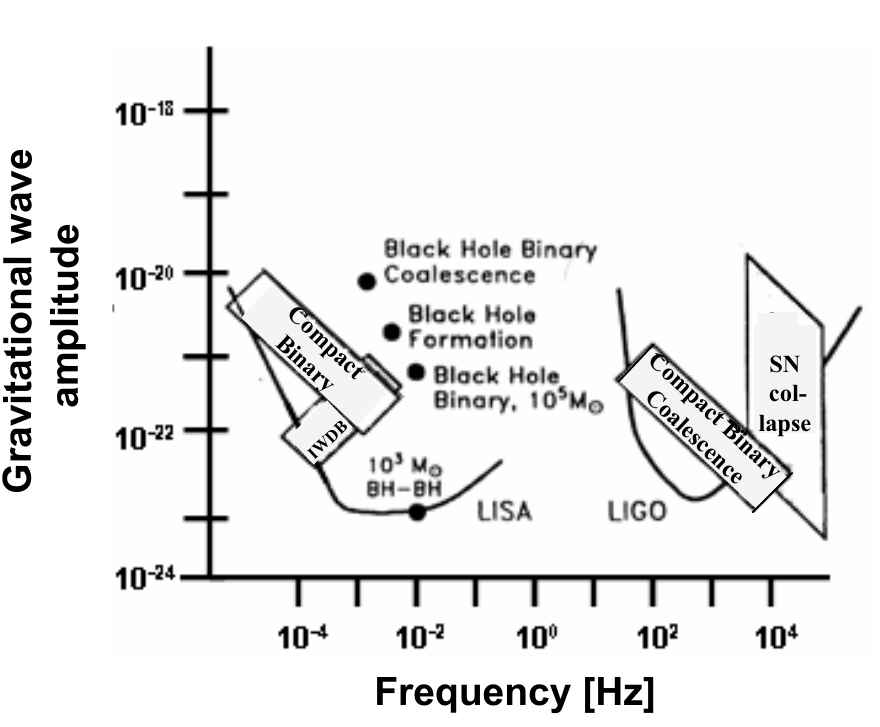
Fig. 6 – Detection efficiency (effective h versus frequency) of the space detector (LISA) and ground based ones under construction (VIRGO, LIGO). It also collects values of h expected from some promising sources, like massive black-holes (taken at z = 1) compact binaries in the galaxy and supernovae taken to be in